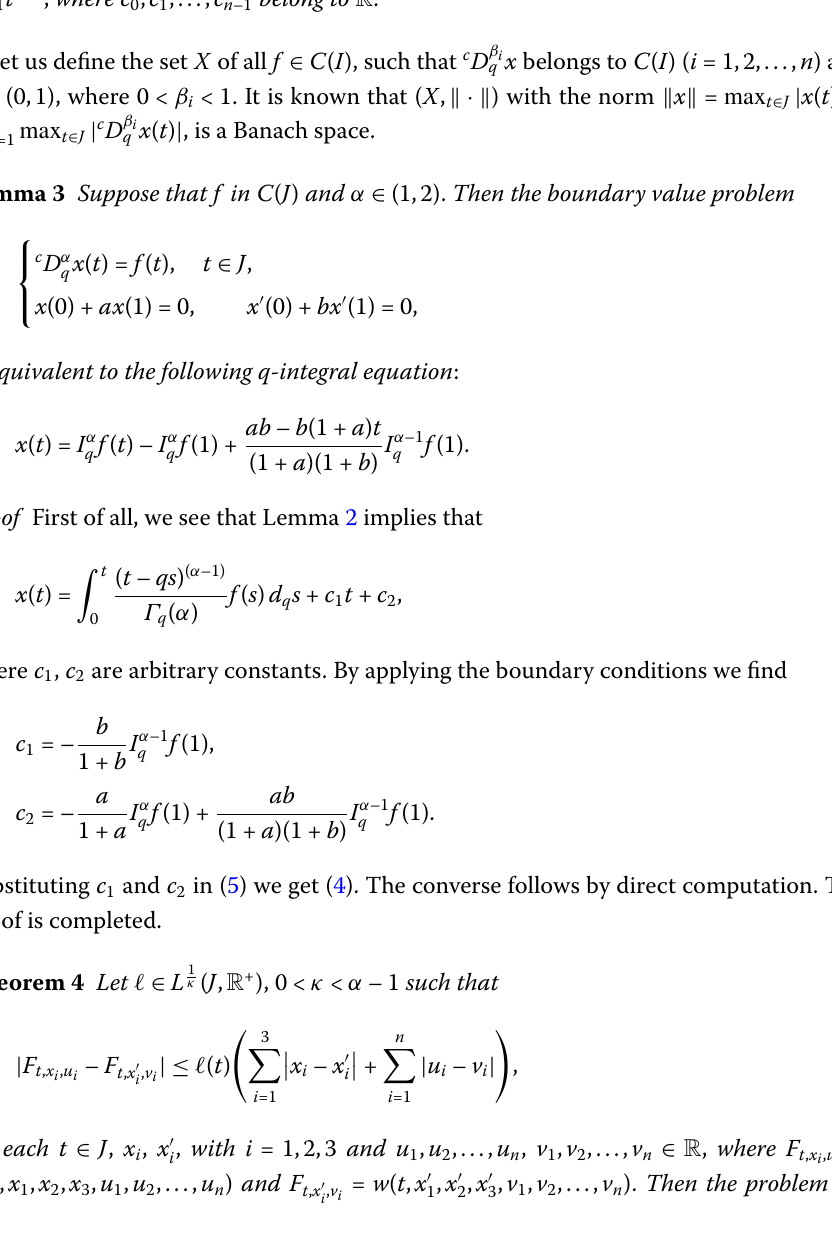
Algorithm 5 The proposed method for calculation of ( I α